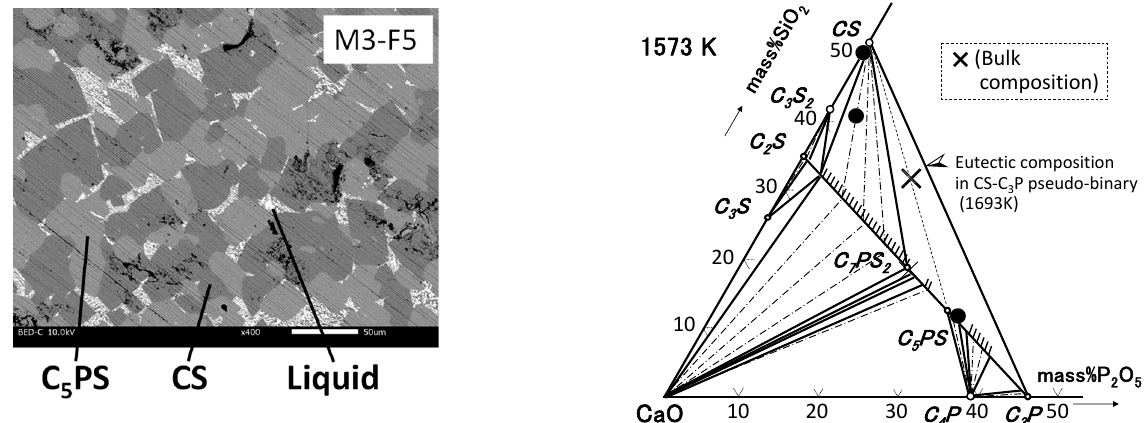
Figure 10. SEM image of M3-F5 (5mass% Fe 2 O 3 ) ( left ) and the phase composition projected on an isothermal section of the CaO-SiO 2 -P 2 O 5 ternary phase diagram at 1573 K ( right ).